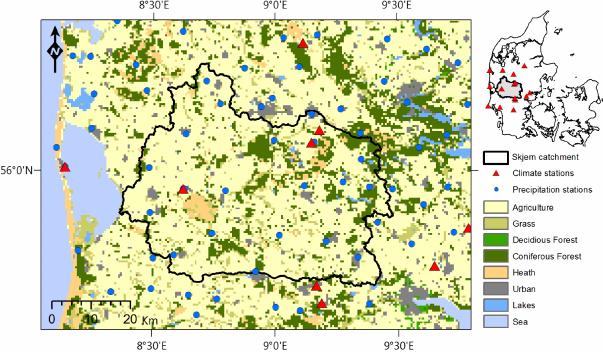
Figure 1. Land use map of the study area: the Skjern river catch- ment in the west of Denmark’s Jutland peninsula. Model input me- teorological data were interpolated from the measurements taken by the stations shown on the